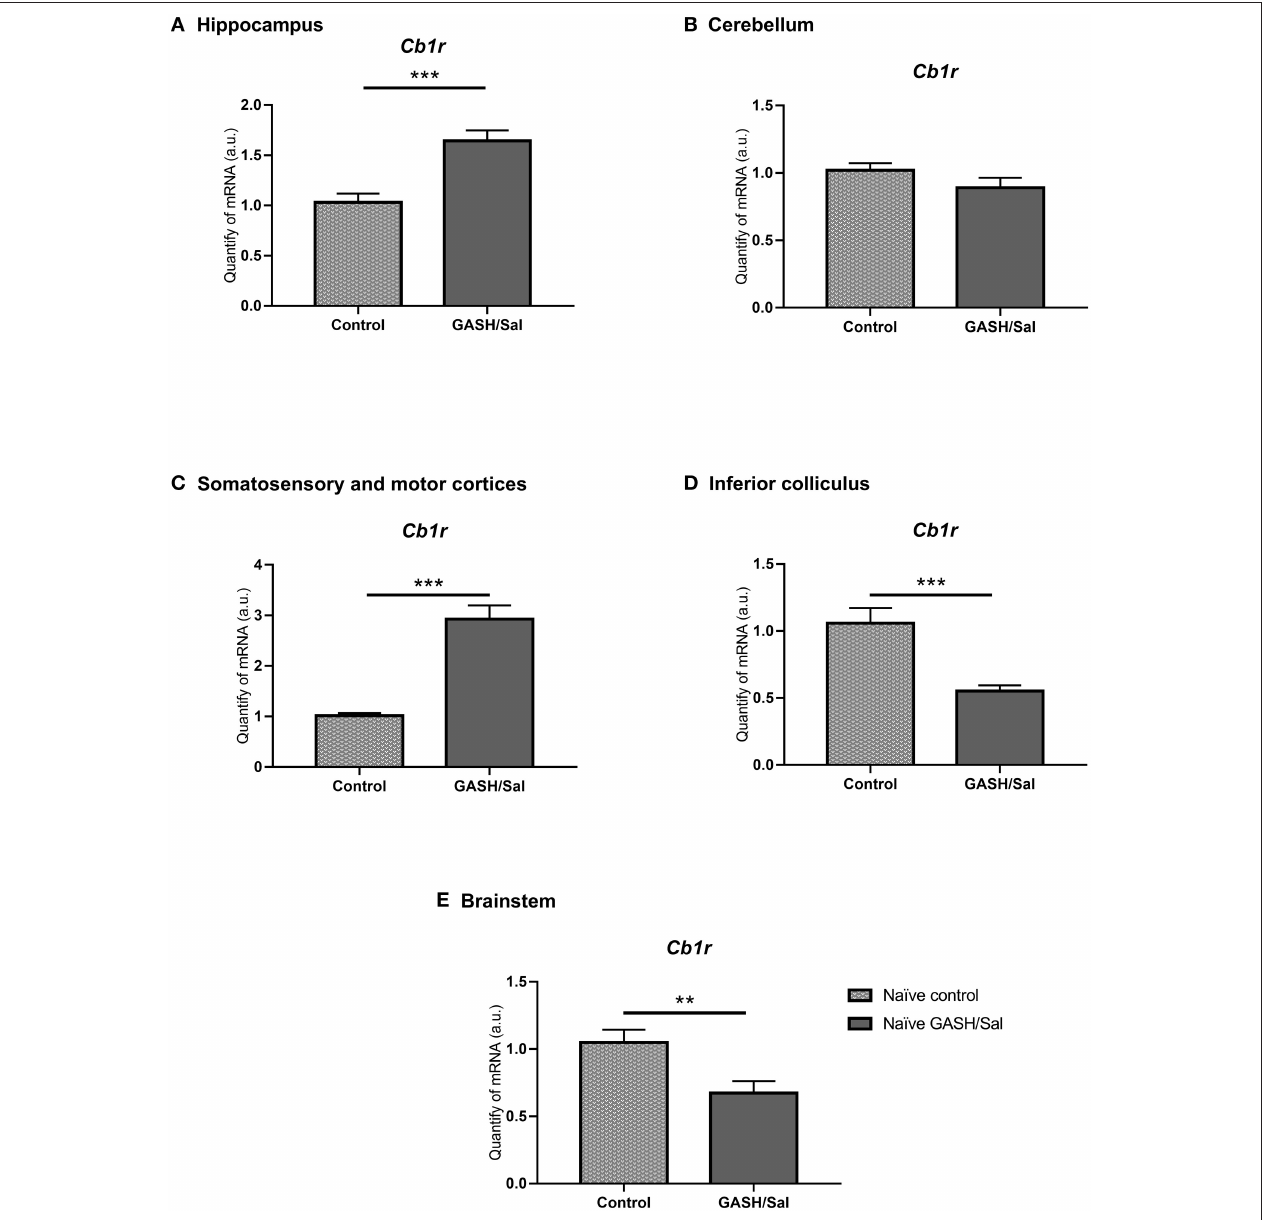
FIGURE 7 | Differences in CB1R mRNA expression levels between GASH/Sal model and control. Relative quantities of transcripts in different areas of the central nervous system of the Syrian golden hamster and the GASH/Sal. In the graph, X-axis: Relative quantities of mRNA in arbitrary units; Y-axis: Experimental groups: naïve Syrian hamster (control); naïve audiogenic group (GASH/Sal). (A) Hippocampus; (B) Cerebellum; (C) Motor and somatosensorial cortices; (D) Inferior colliculus; (E) Brainstem Bars represent mean ± SEM. Statistical analyses: Unpaired t -test. * p ≤ 0.01; ** p ≤ 0.001, and *** p ≤